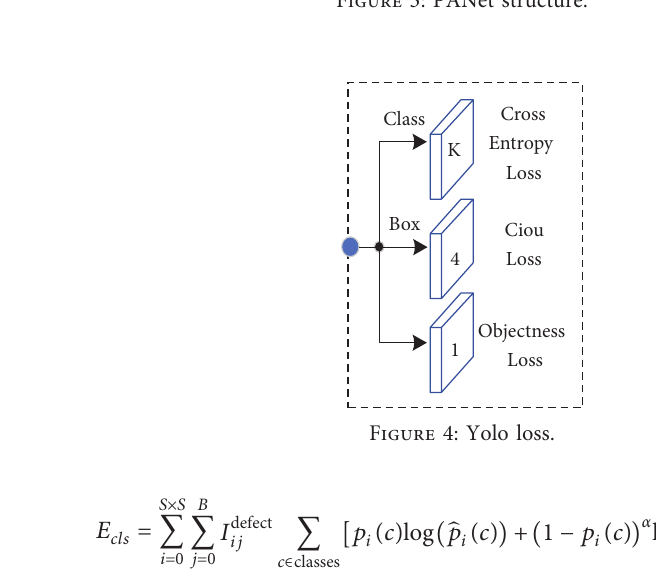
Figure 3: PANet structure.